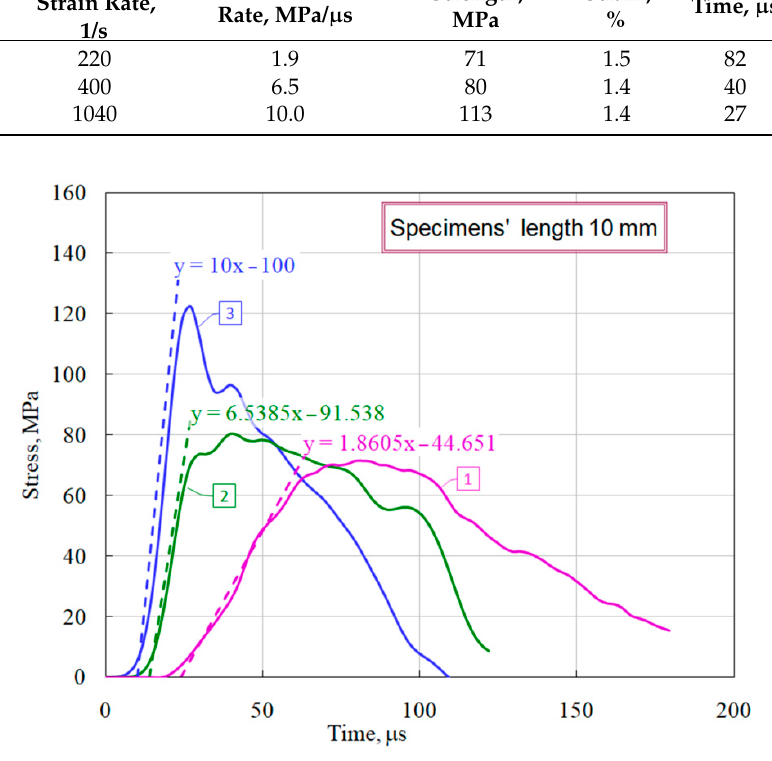
Figure 8. Definition the stress growth rate.